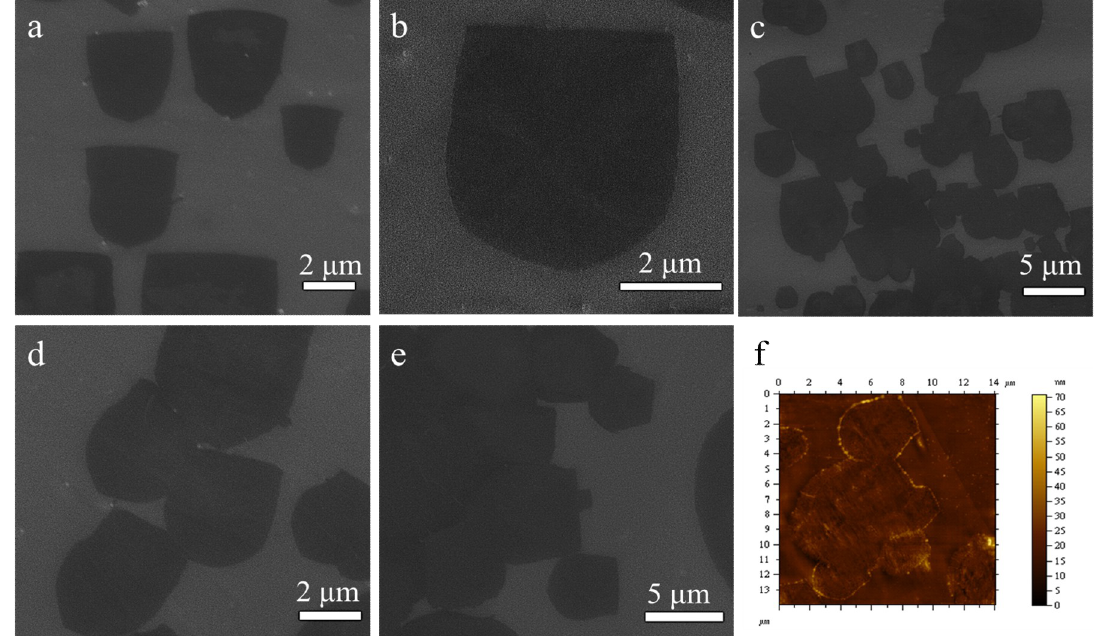
Figure 2. ( a ) SEM image of the U-shaped graphene domains on the copper foil. ( b ) The magnified SEM image of an individual U-shape graphene. ( c , d ) SEM images of the coalescence of the different graphene domains. ( e ) A SEM image of the continuous graphene film. ( f ) The atomic force microscopy (AFM) image of the merging graphene domains.